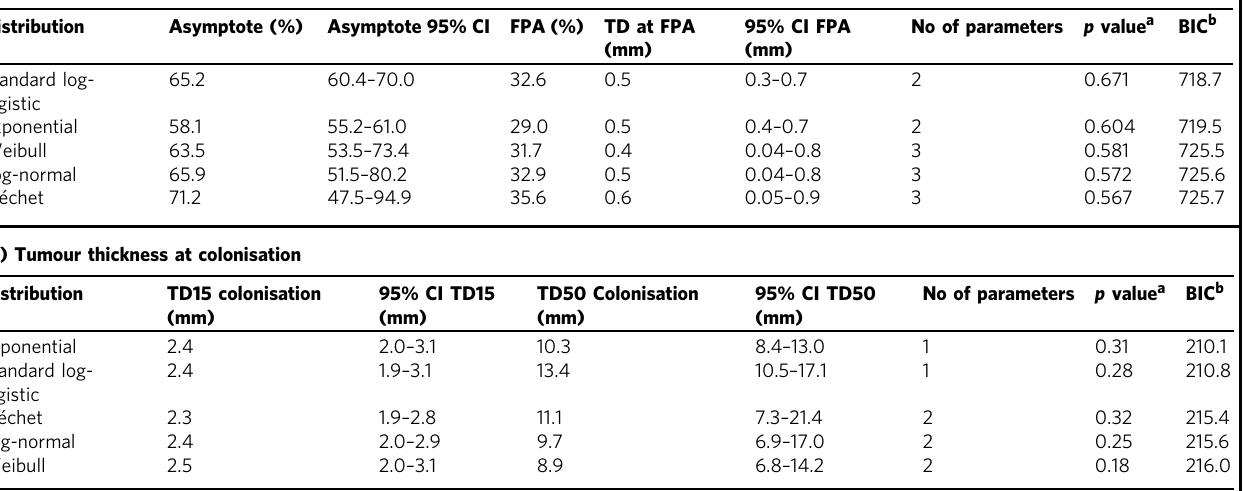
Table 1 Identi fi cation of best fi tting model for tumour thickness at dissemination and colonisation (a) Tumour thickness at dissemination